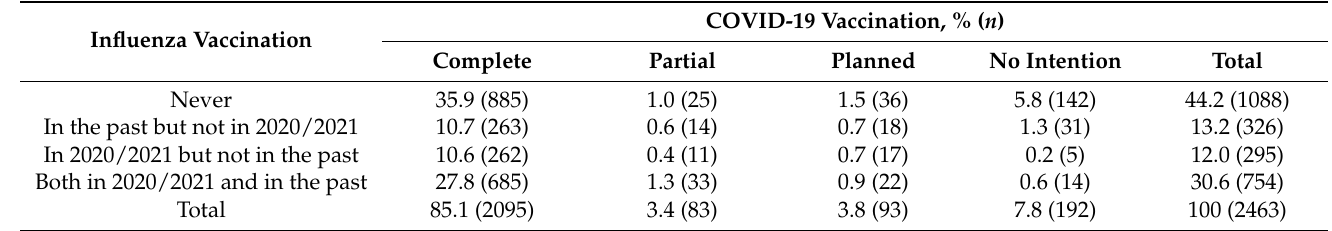
Table 2. Cross-tabulation of the declared uptake of COVID-19 and seasonal influenza vaccines ( n = 2463). COVID-19 Vaccination, % ( n Influenza Vaccination